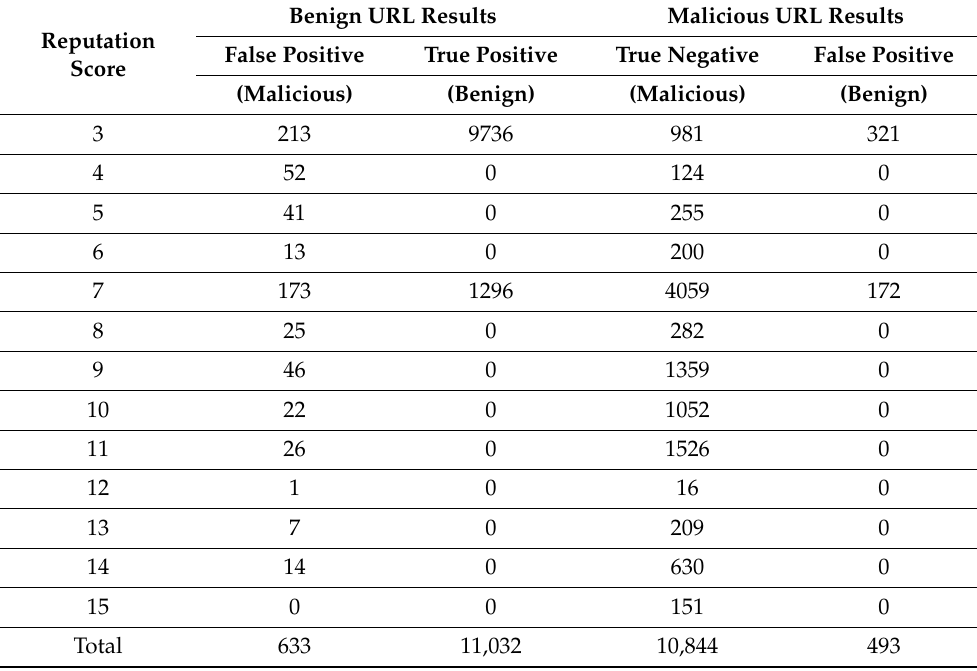
Table 6. Reputation Score Mapping based on Ensemble Prediction